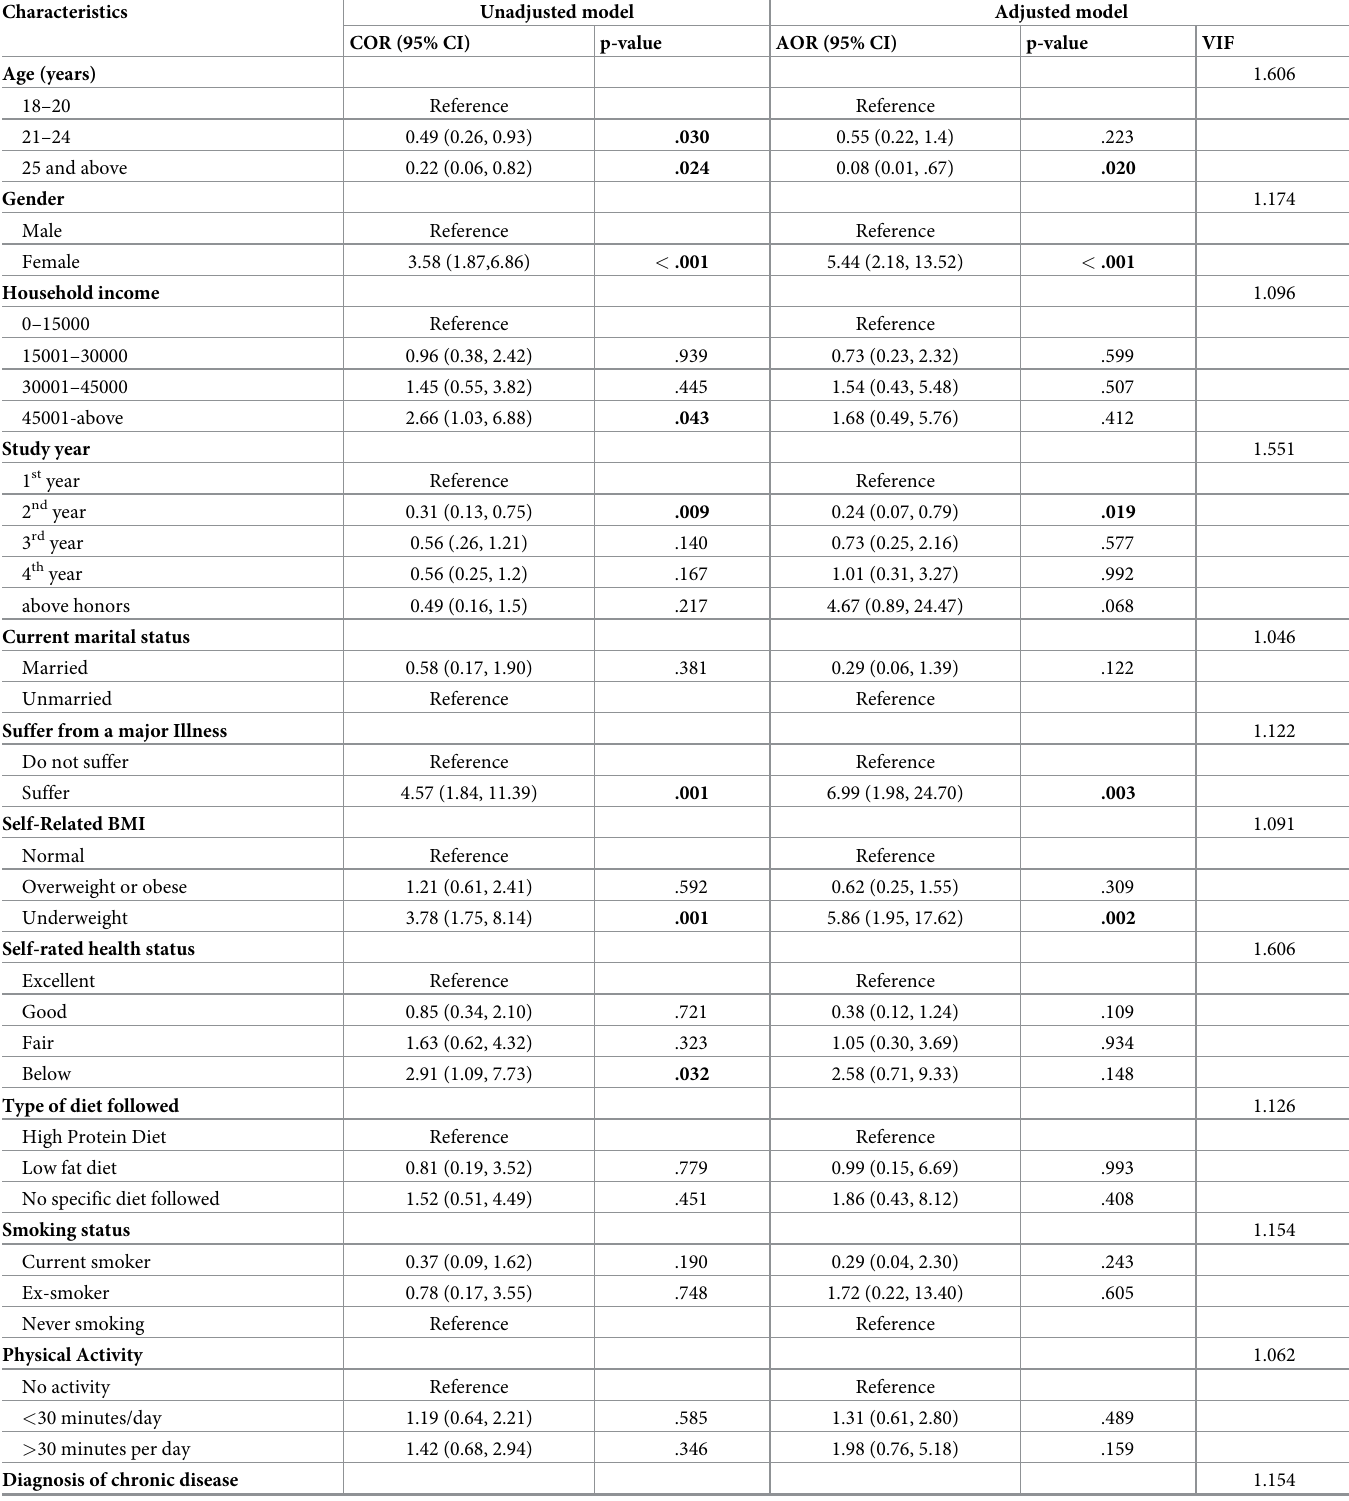
Table 4. Regression analysis showing the factors associated with the use of dietary supplement among Bangladeshi university students (N = 390).